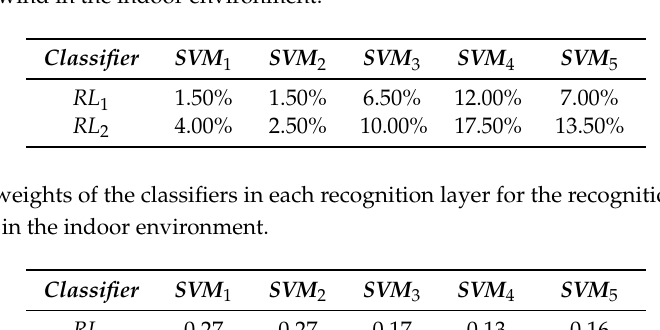
Table 2. Classification errors of the classifiers in each recognition layer for the recognition of adults, dogs and warm wind in the indoor environment.